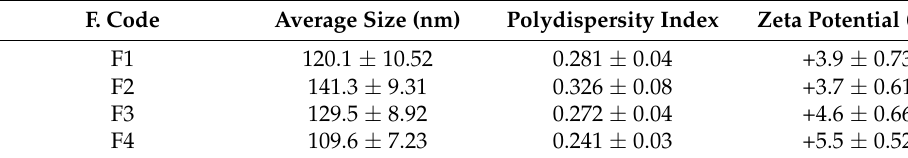
Table 1. Results of the size, PDI and zeta potential of the emulsions.